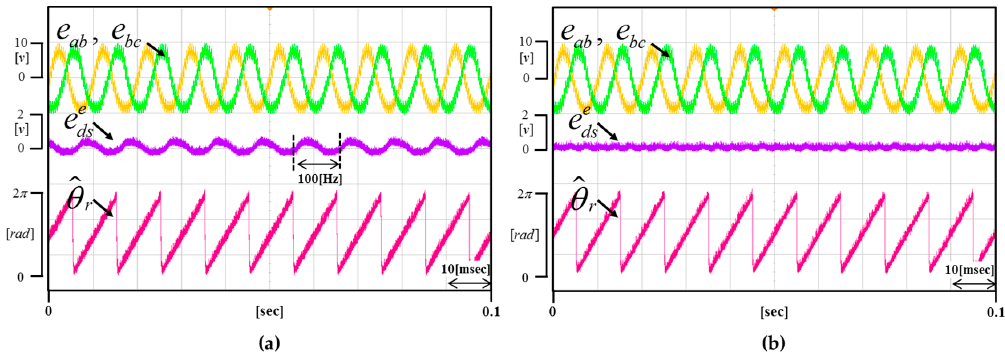
Figure 15. ( a ) Waveform of the not applied proposed method ( b ) Waveform of the applied proposed